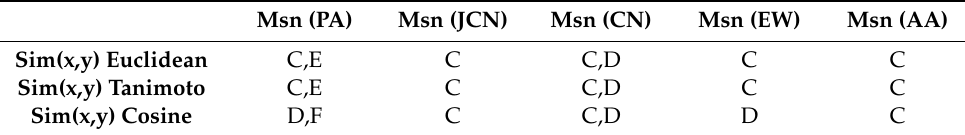
Figure 8. Similarity for neighbor based metrics.